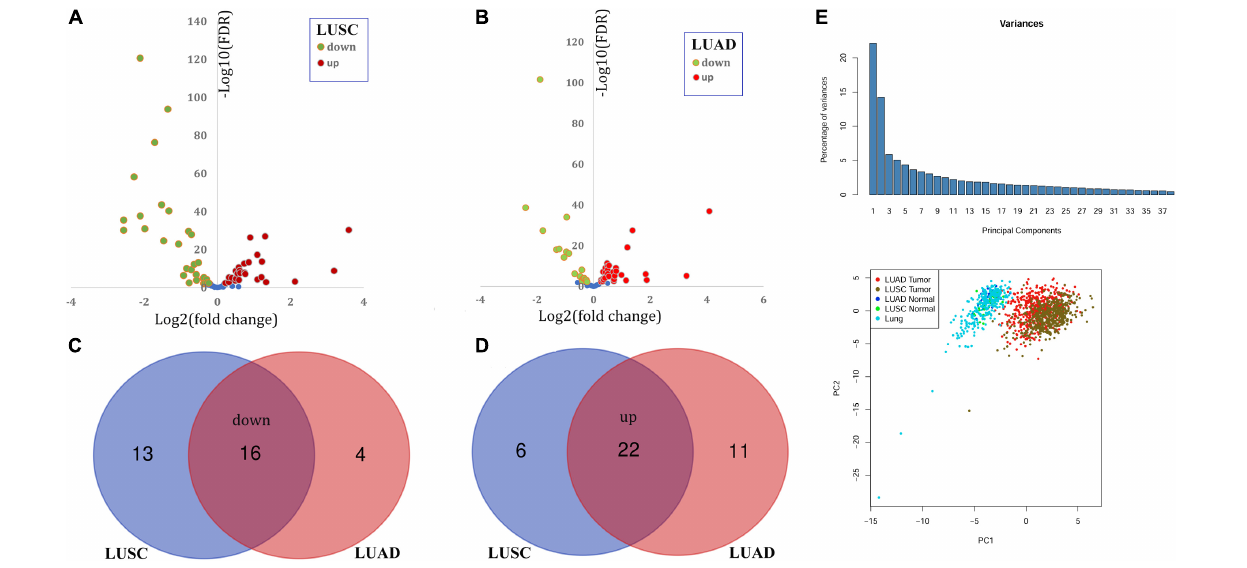
Frontiers in Genetics |